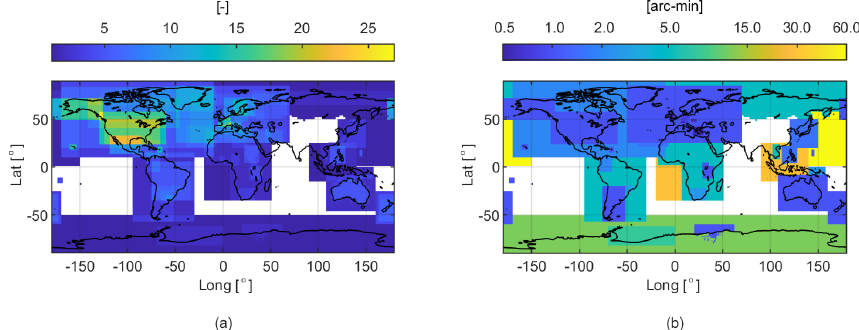
Figure 1. Geoid repository: (a) number of available geoid models covering the same area, where blank means missing data; (b) spatial resolution of the gridded geoid models available at the ISG, where the colour bar shows the highest spatial resolution available per location, on a log-10 scale with units in arcmin.